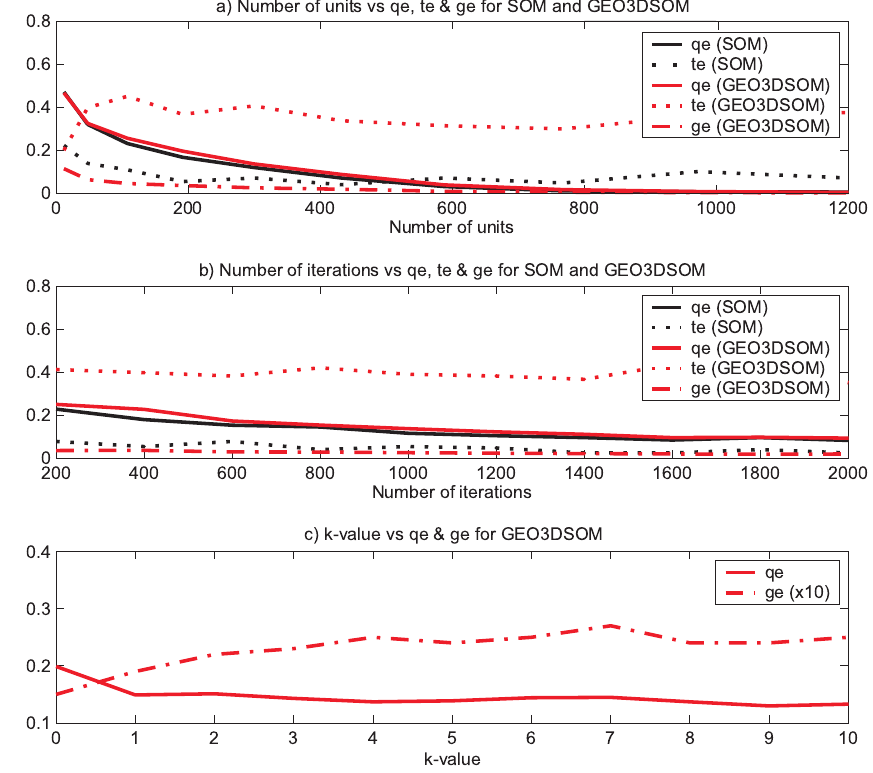
Fig. 7. Results of the sensitivity analysis with respect to (a) the number of units, (b) the number of iterations and (c) the value of the geographical tolerance k for SOM and